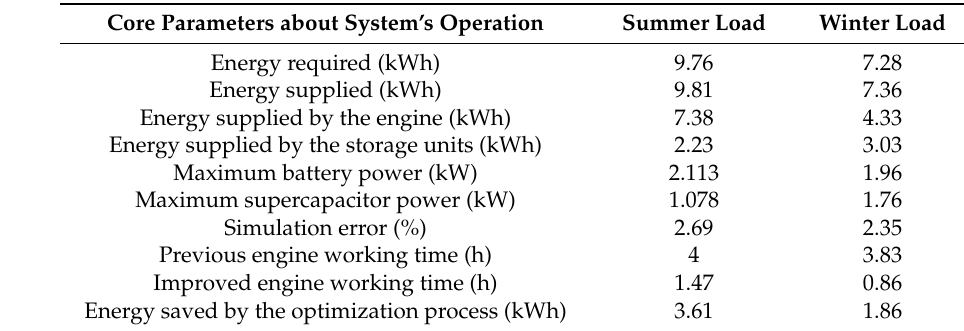
Table 3. Cost analysing of the system.